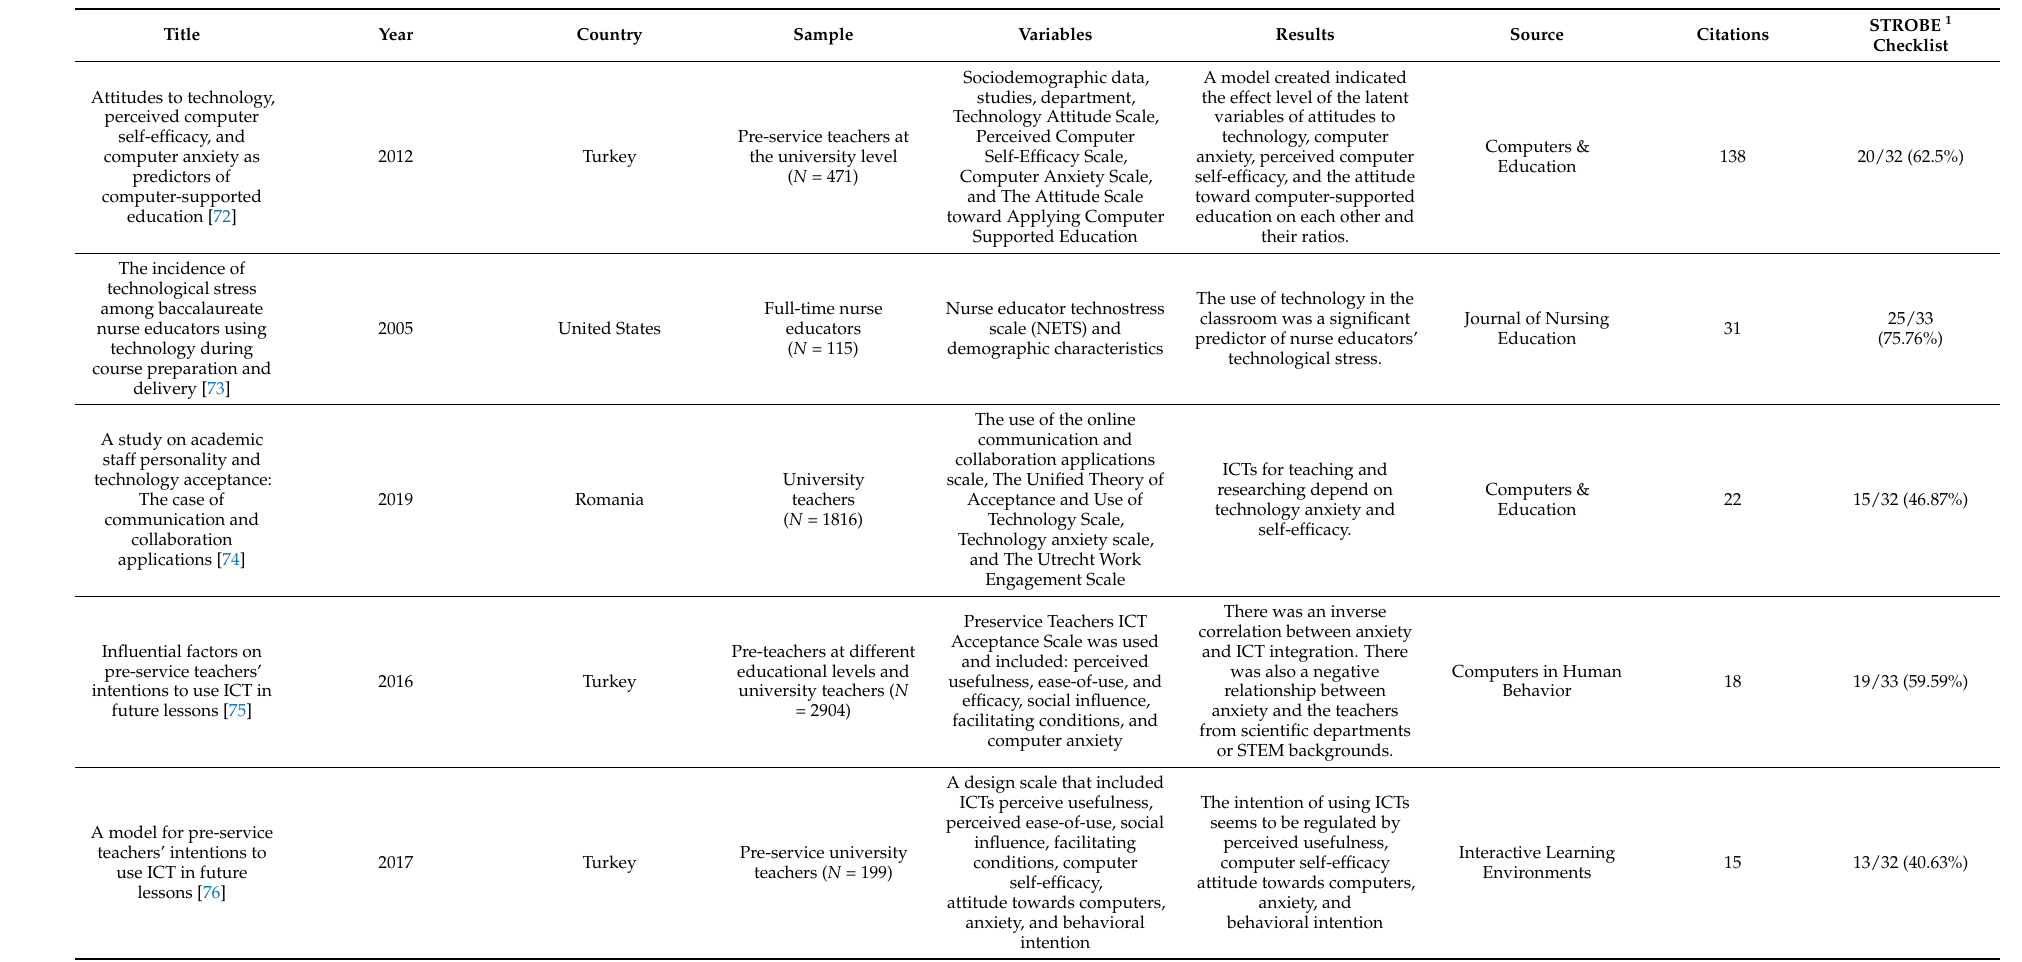
Table 6. The five most-cited observational articles of the bibliometric